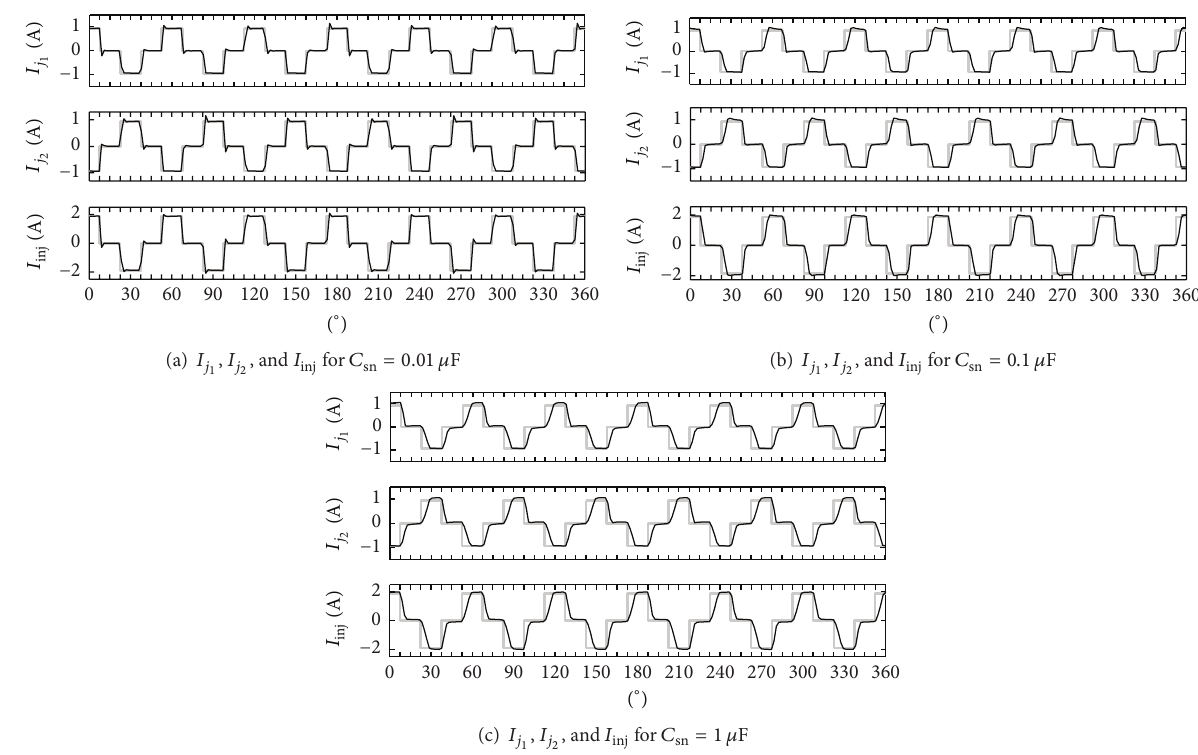
(c) 𝐼 𝑗 , 𝐼 𝑗 , and 𝐼 inj for 𝐶 sn = 1𝜇 F 1 2